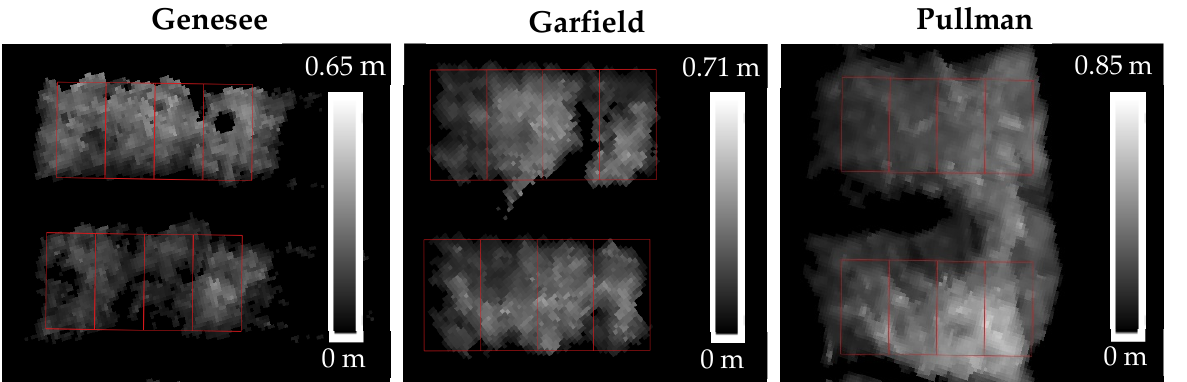
Figure 8. Part of CHM model at the PM stage with plot segmentation polygon (red color) for CH and crop-coverage area extraction.